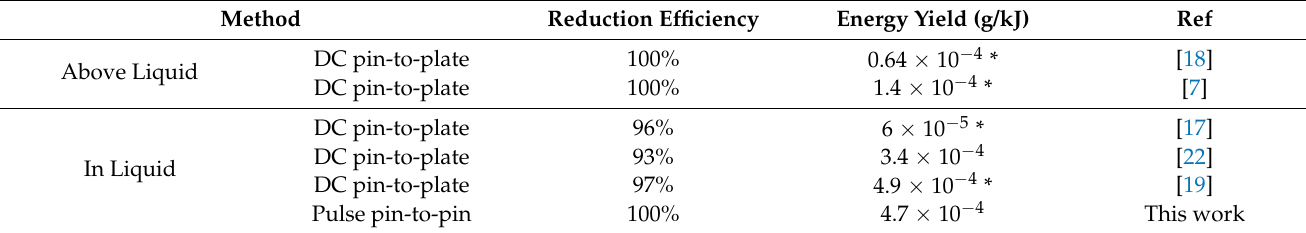
Table 3. Comparison of reduction efficiency and energy yield for Cr(VI) reduction by plasma liquid interaction processes. * These values have been calculated using Equation (2) and data of the